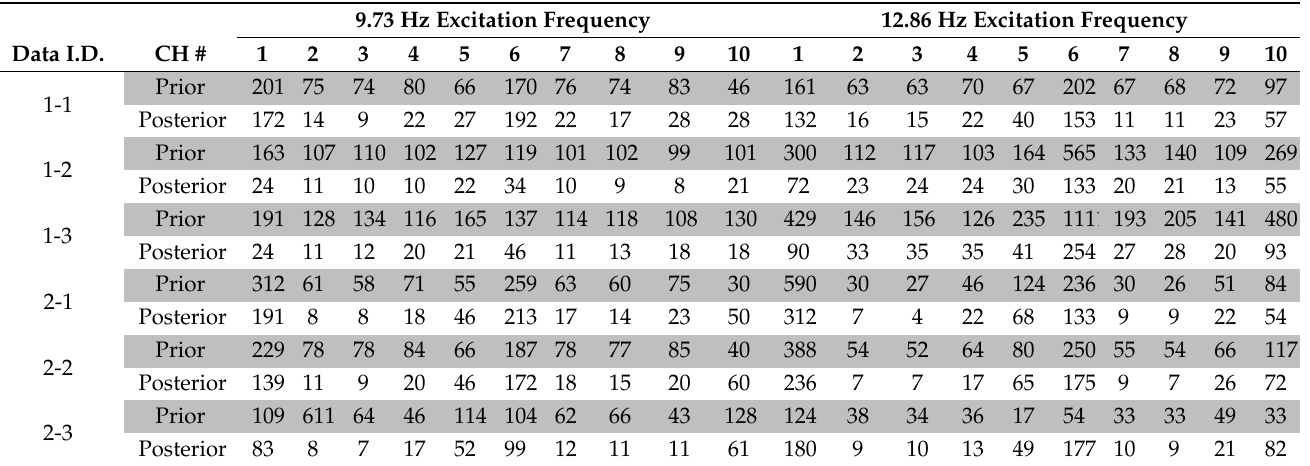
Table 5. RRMSEs (%) between the measurements and FE-predicted responses from the prior and posterior